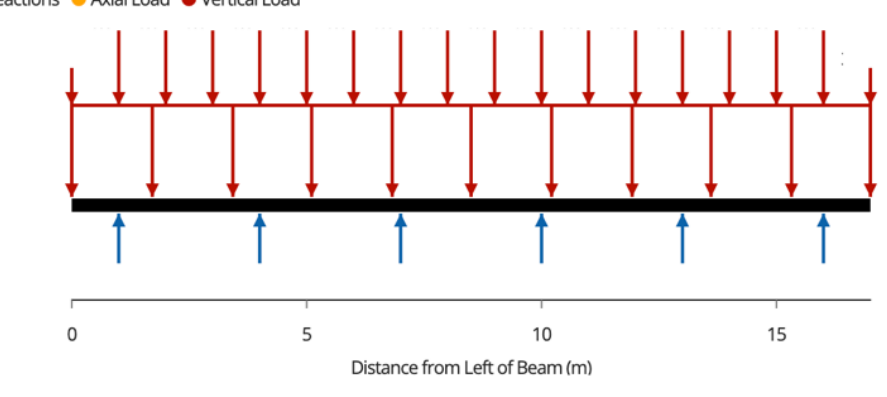
Figure A3. Continuous beam free-body diagram.